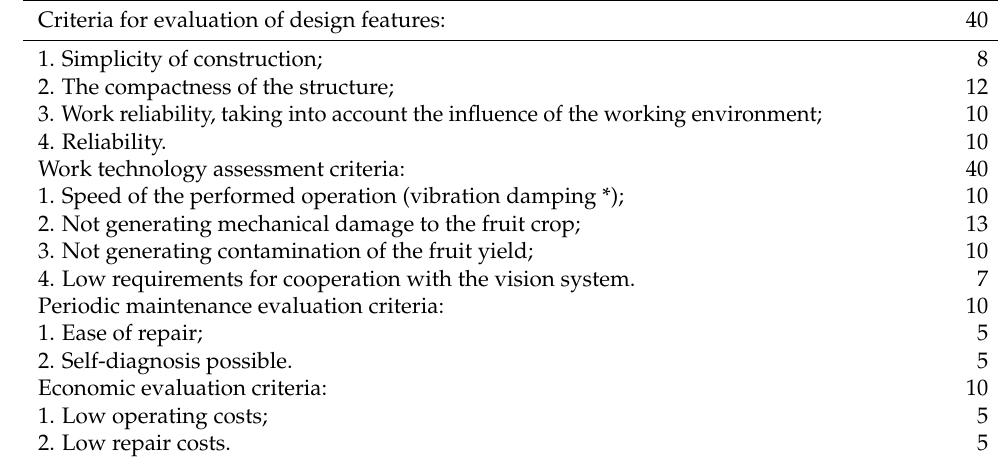
Table 2. Weights in the criterion assessment of the analyzed solutions.